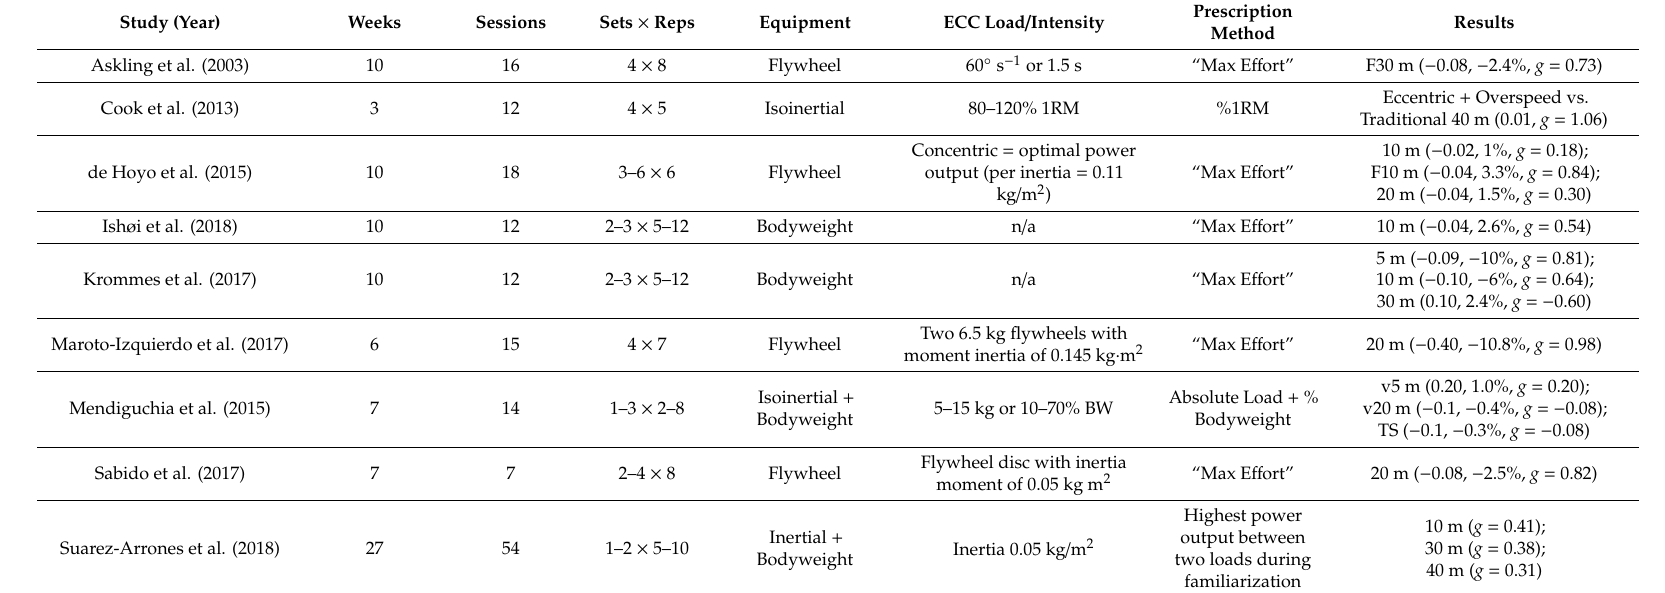
Table 4. Eccentric training intervention characteristics for speed